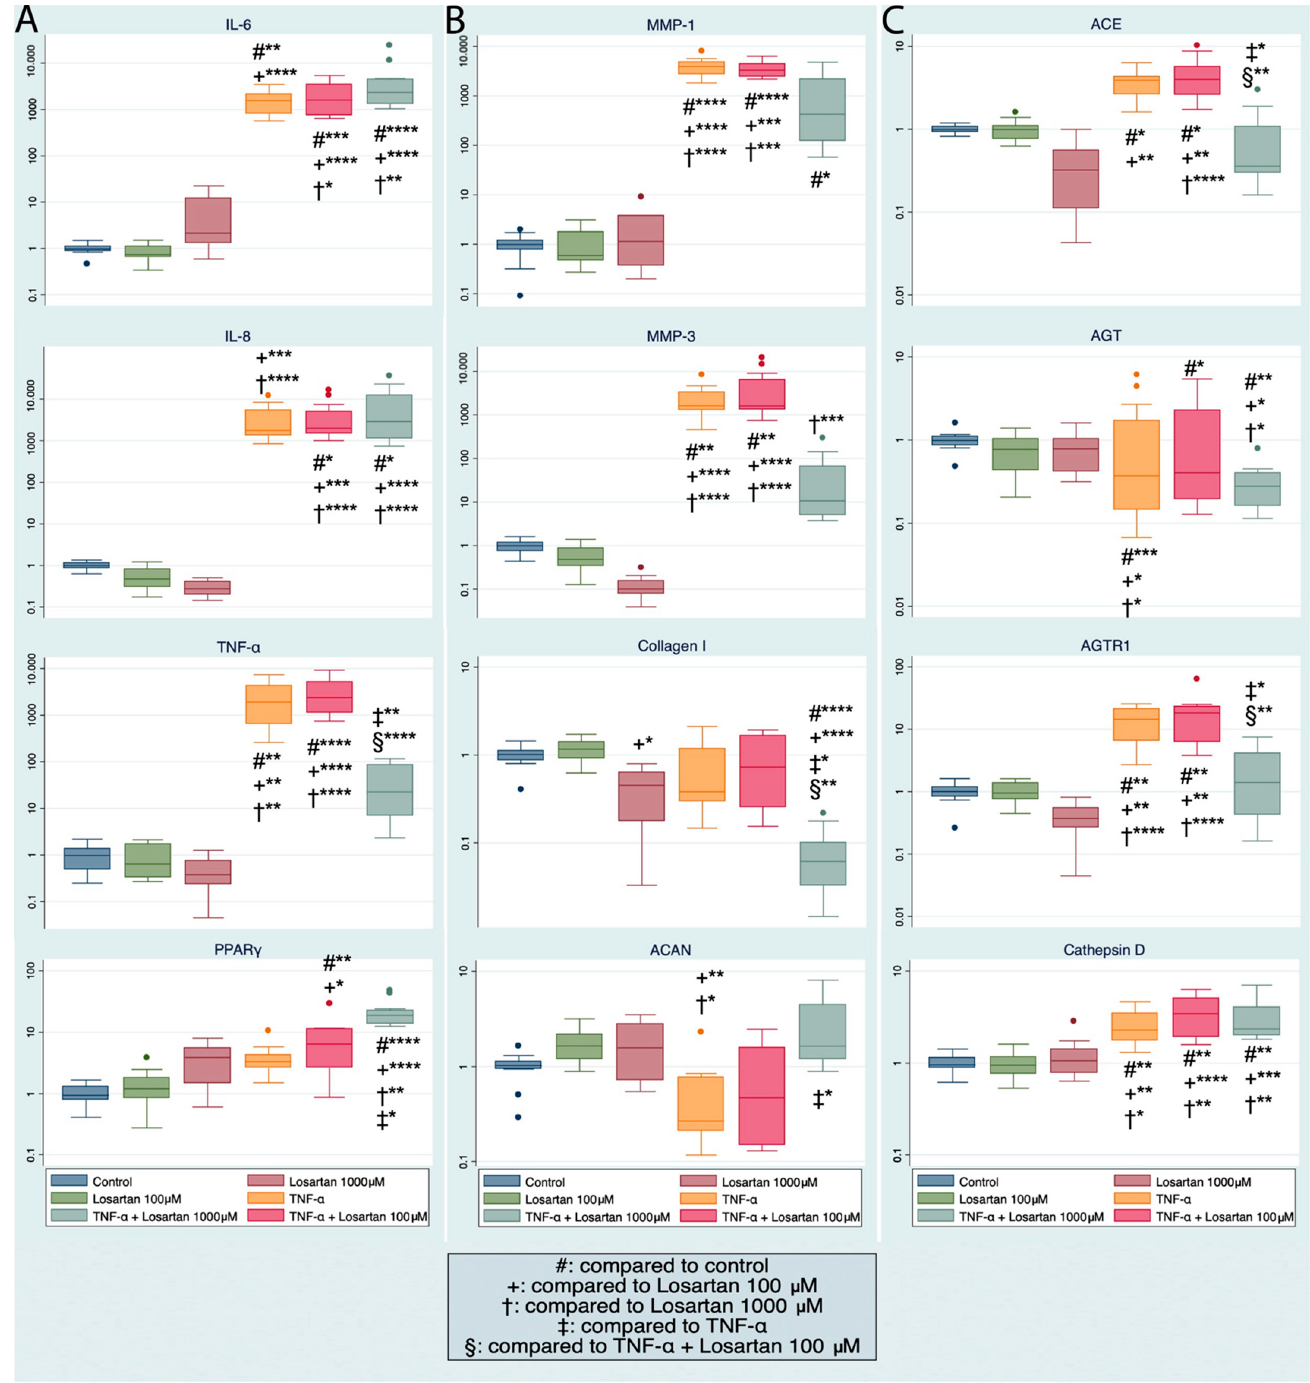
Figure 3. Gene expression of inflammatory ( A ), tissue remodeling ( B ), and tRAS markers ( C ) among the experimental groups. Gene expression was normalized to Day 0 (baseline) values. Data from four donors assessed in triplicate are shown ( n = 12). #: compared to control; +: compared to losartan 100 μ M; †: compared to losartan 1000 μ M; ‡: compared to TNF- α ; §: compared to TNF- α + losartan 100 μ M; * p < 0.05; ** p < 0.01; *** p < 0.001; **** p < 0.0001.